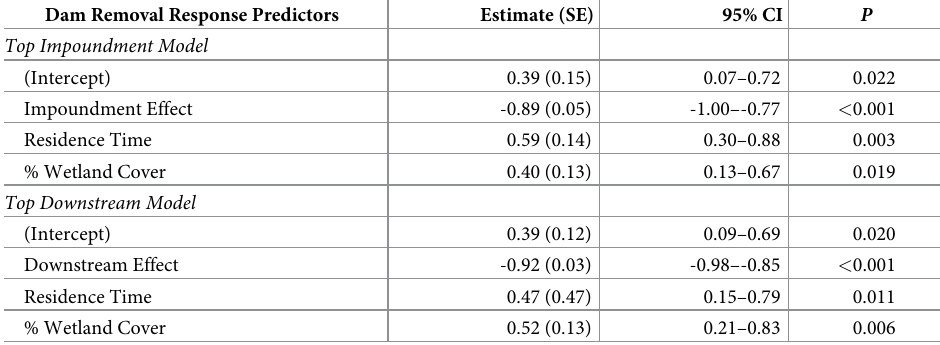
Table 9. Standardized parameter estimates for the two top-ranked candidate models explaining variation in impoundment and downstream dissolved oxygen (DO) responses to dam removal. Estimates of fixed effects are shown with standard errors (SE), 95% confidence intervals (CI), and p-values ( P ).